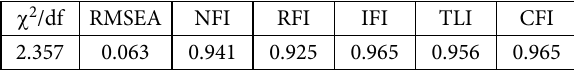
Table 3. Cronbach’s α value of the variables Construct